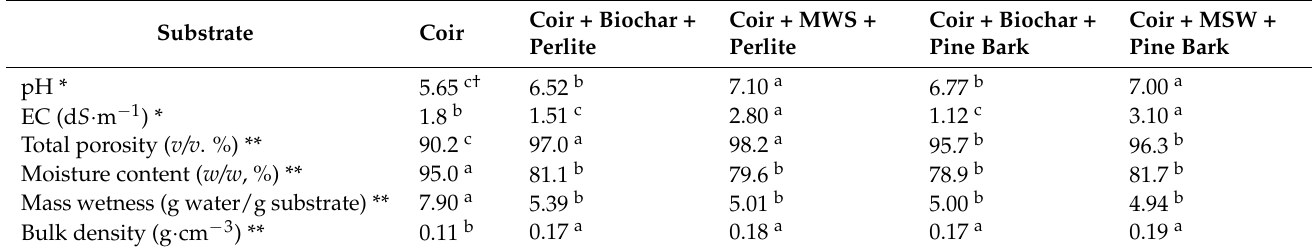
Table 1. Initial physicochemical properties of the